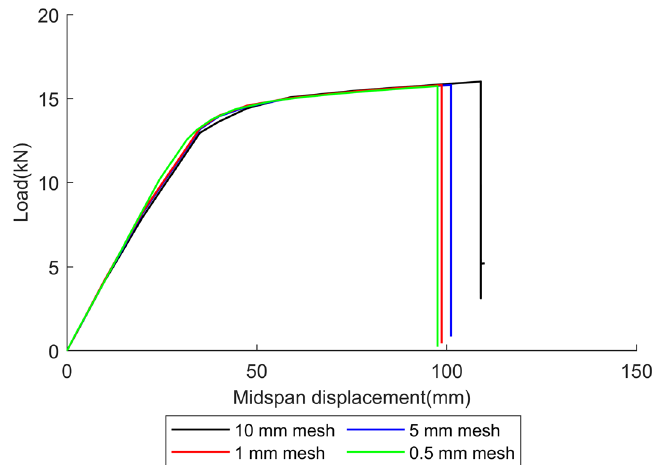
Figure 11. The load–displacement curves of four mesh strategies.